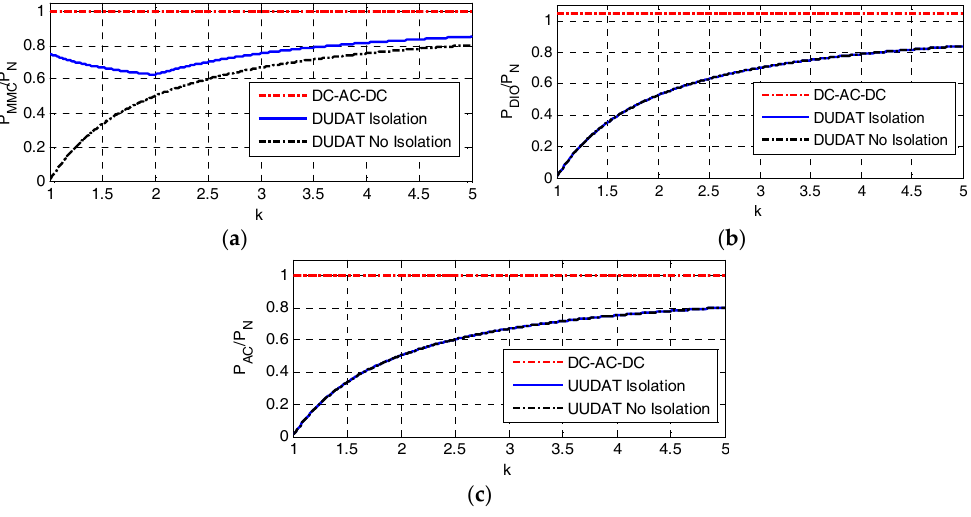
Figure 5. Power rating of the MMC, DIO and AC transformer in a DUDAT versus stepping ratio. ( a ) Power rating of MMC; ( b ) Power rating of uncontrolled rectifier; ( c ) Power rating of transformer.